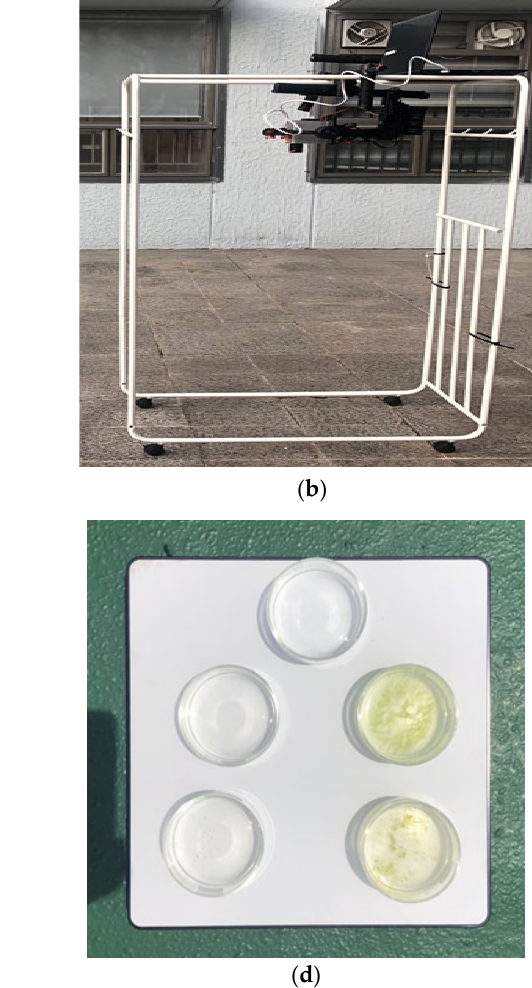
Figure 5. Hyperspectral image acquisition equipment (( a ) HSI and gimbal se tt ing—method for correcting the shake of the HSI; ( b ) hyperspectral system—device con fi guration for imaging algal samples; ( c ) white plate (99.9%)—white reference plate used for radiation correction; ( d ) sample se tt ing—algal samples for collecting hyperspectral data.)